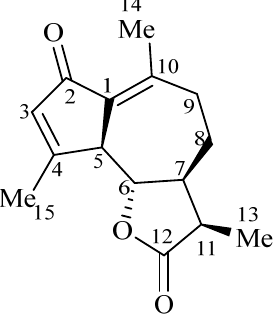
Figure 1. Chemical structure of achillin compound.